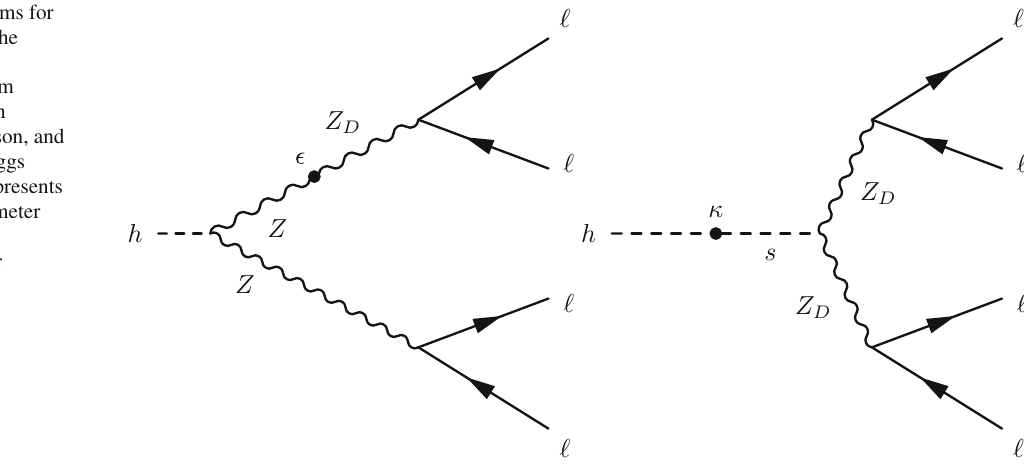
Fig. 1 Feynman diagrams for Higgs boson decay via the kinetic-mixing (left) or Higgs-mixing mechanism (right) [7]. The symbol h represents the Higgs boson, and s represents the dark Higgs boson. The symbol ε represents the kinetic-mixing parameter while κ represents the Higgs-mixing parameter